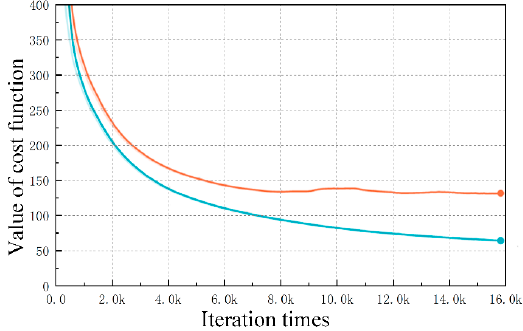
Figure 8. Curve of total cost function Loss.